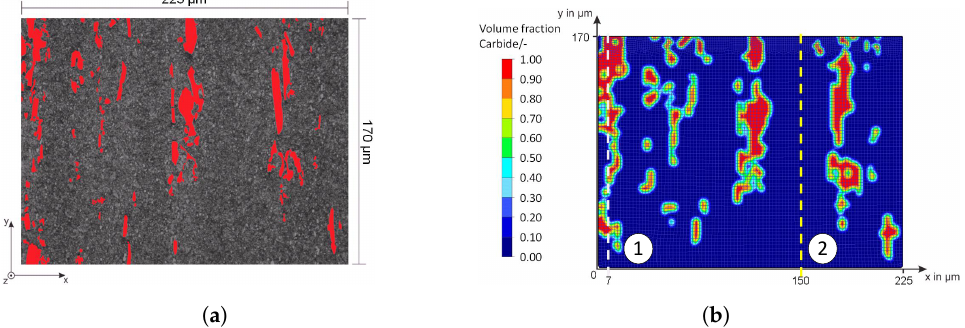
Figure 5. 2D model based on micrographs of the high-alloy tool steel X153CrMoV12. ( a ) Micrograph of X153CrMoV12 with characteristic chromium carbides (red) in the ferrite ( α )/martensite ( α (cid:48) ) matrix (grey). The binary color scheme allows the differentiation between the specific phases and the coupling to the 2D model in DEFORM™. ( b ) The coupled mesh with volume fractions of the chromium carbides in the matrix. Carbide-rich areas are at place 1 (cid:13) (7µm), and carbide-poor areas are at place 2 (cid:13)